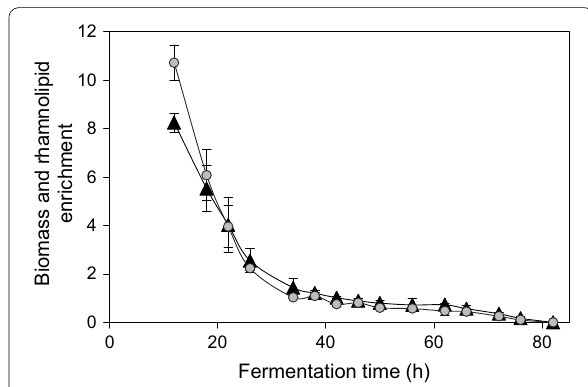
Fig. 4 Time course of differential bacterial (circles) and rhamnolipid (triangles) enrichment in the foam during integrated fermentations. Foam samples were taken at the sampling port on the foam exit at the top of the bioreactor. The values for bacterial and rhamnolipid enrichment were calculated according to Eq. 4